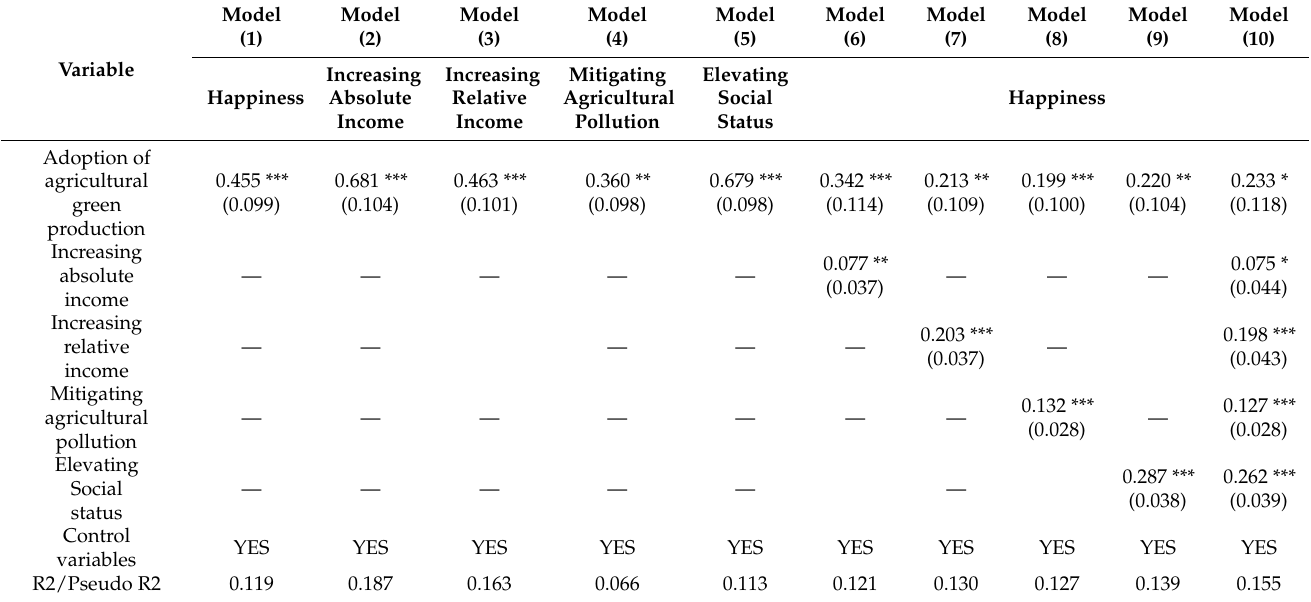
Table 4. Estimation results of the mediation effect of adopting agricultural green production on farmers’